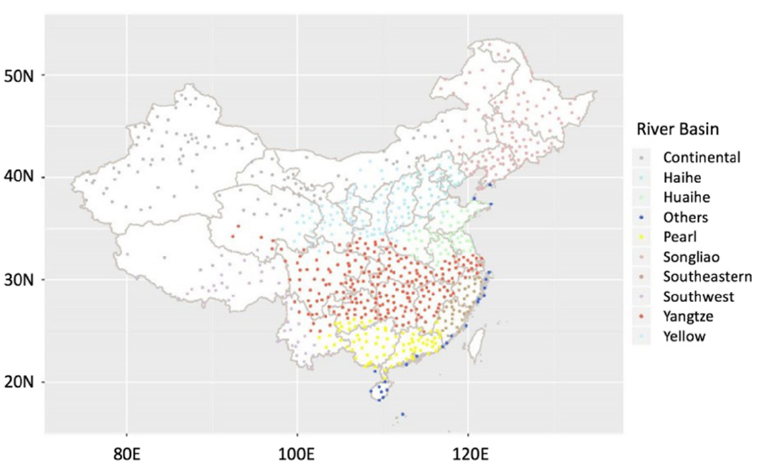
Figure 1. Map of the study area (5–55° N, 75–135° E) and locations of the weather stations in China.